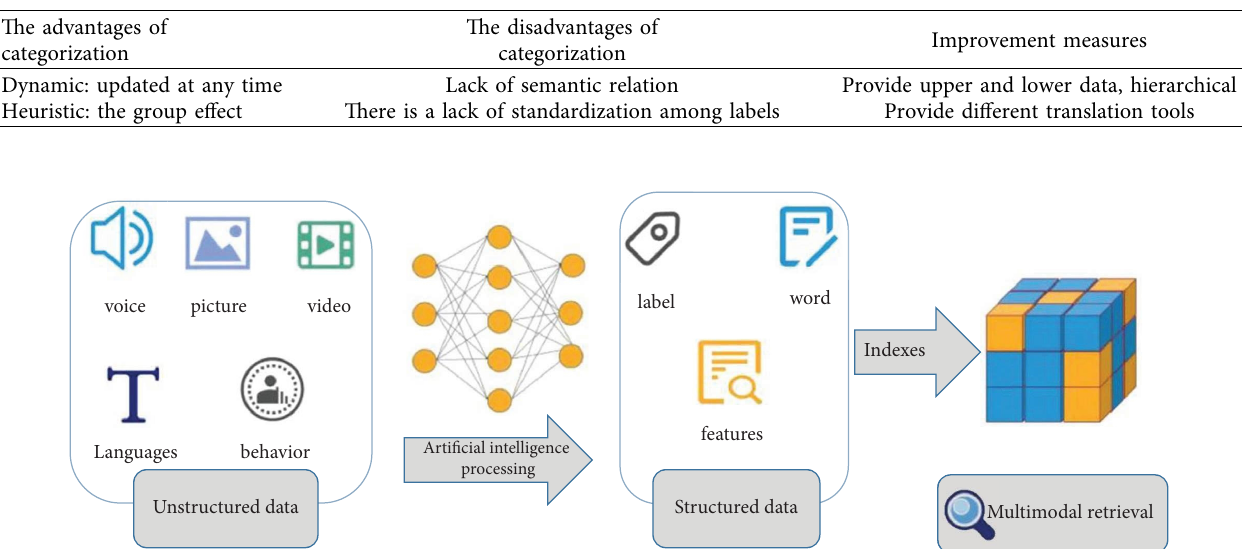
Table 4: Advantages and disadvantages of categorization.